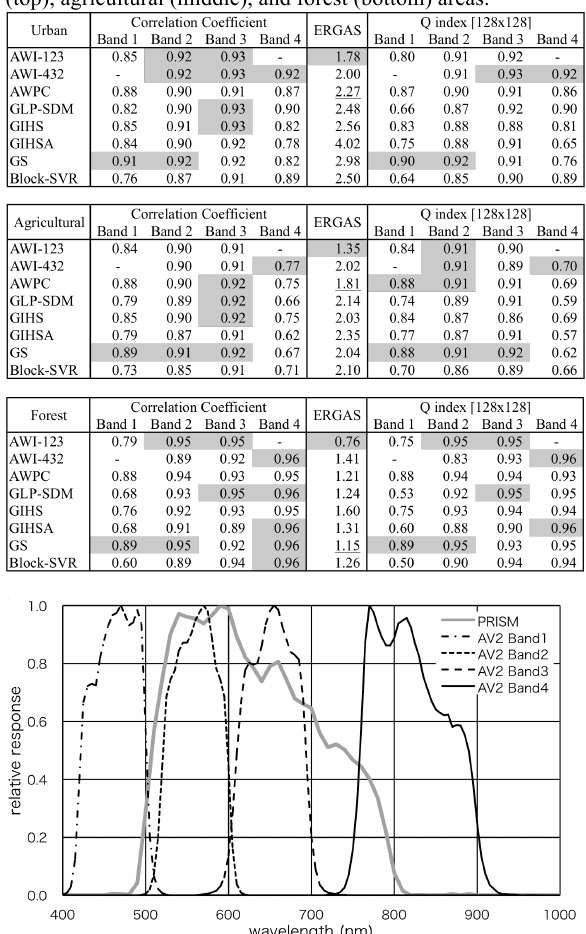
Figure 6. Spectral response of PRISM and